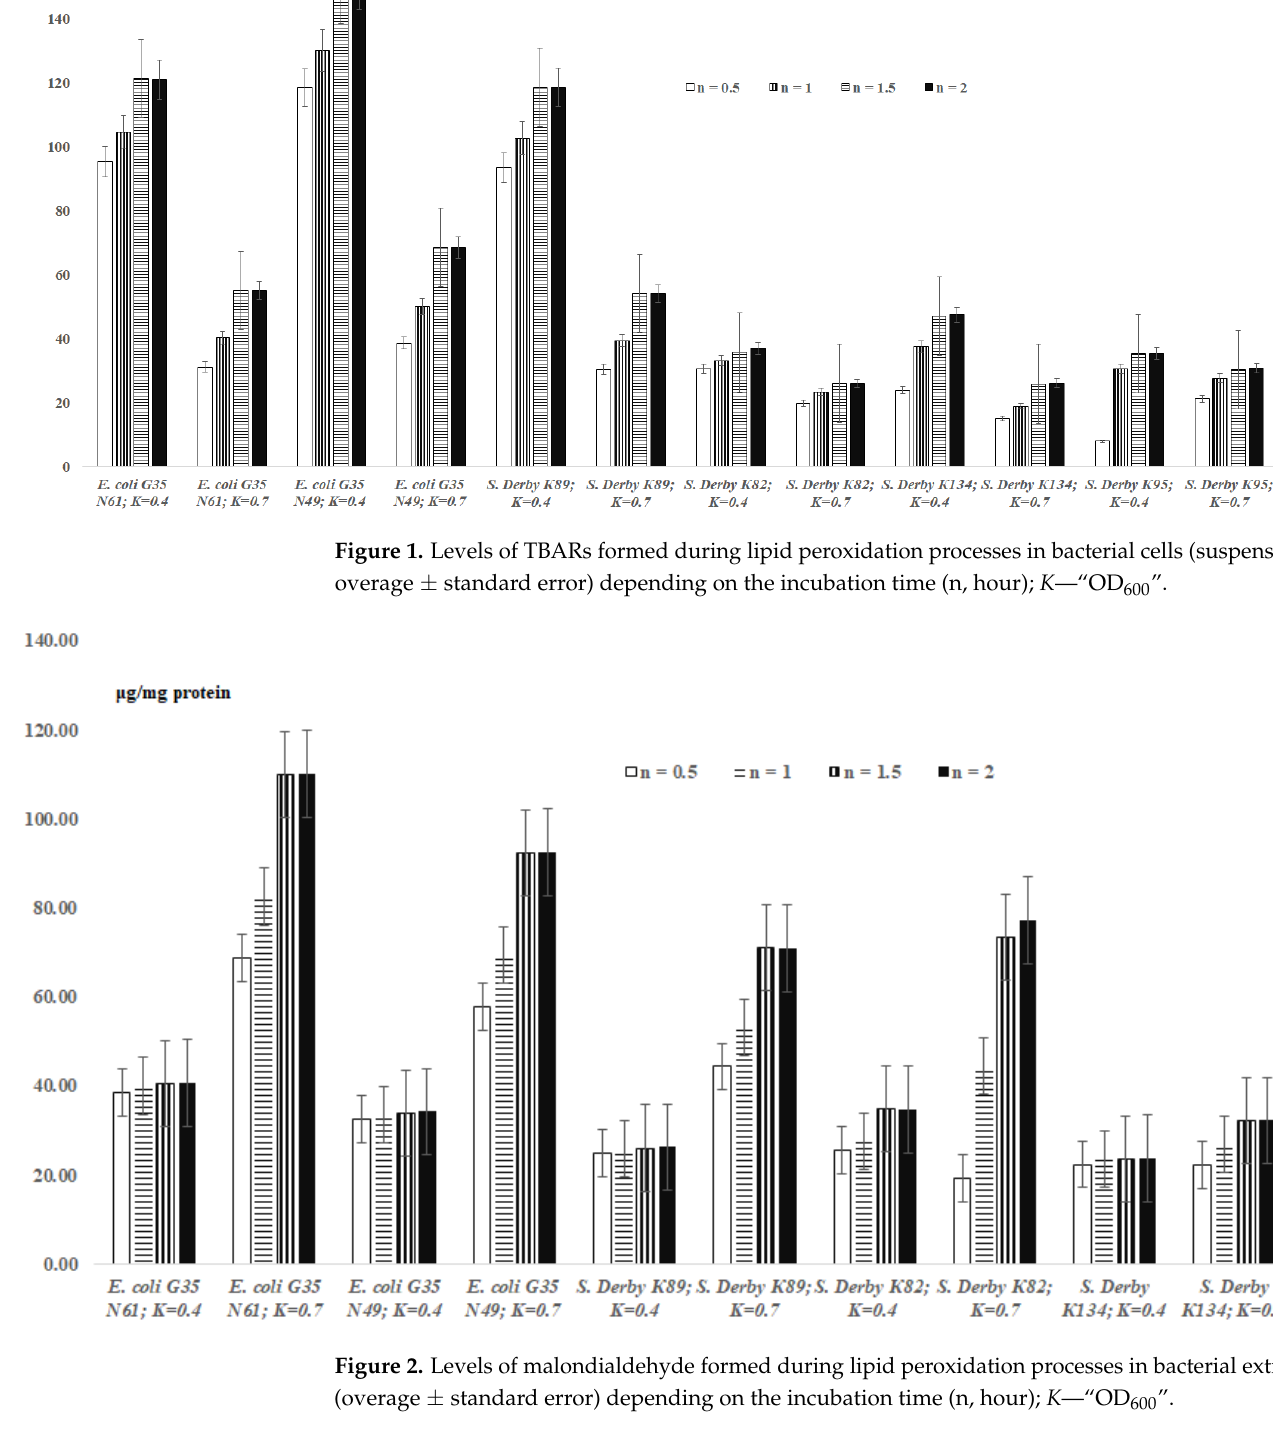
Figure 2. Levels of malondialdehyde formed during lipid peroxidation processes in bacterial ex- tracts (overage ± standard error) depending on the incubation time (n, hour); K —“ OD 600 ”.